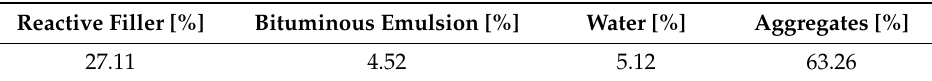
Figure 1. Particle size distribution curve. Table 2. Laboratory RTM’s